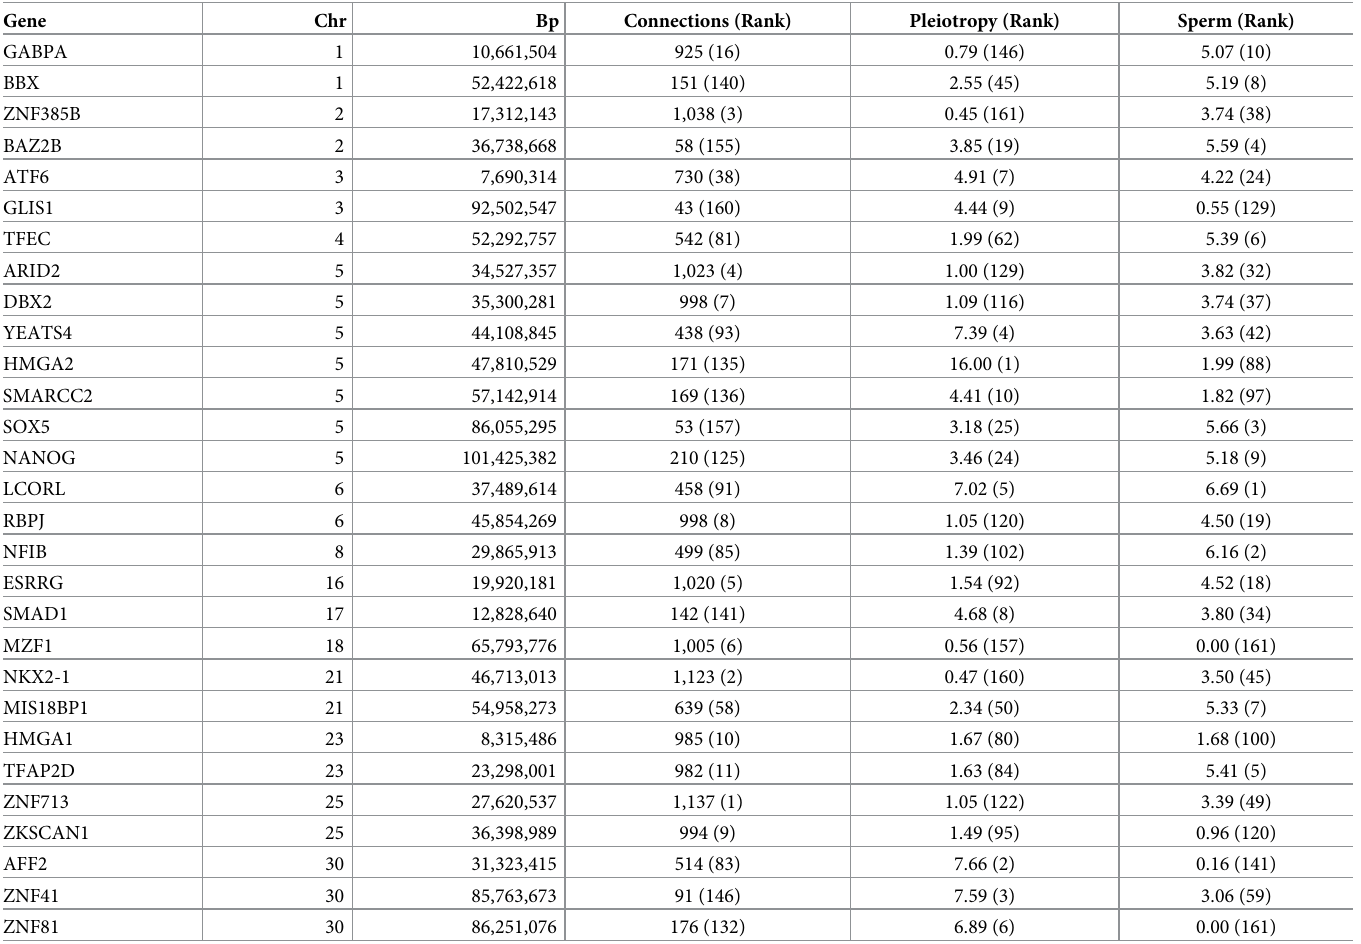
Table 4. Gene identity and location of candidate causal mutation for 29 TF based on being in the top 10 rank of either of number of network connections, pleiot- ropy test or expression abundance in sperm.